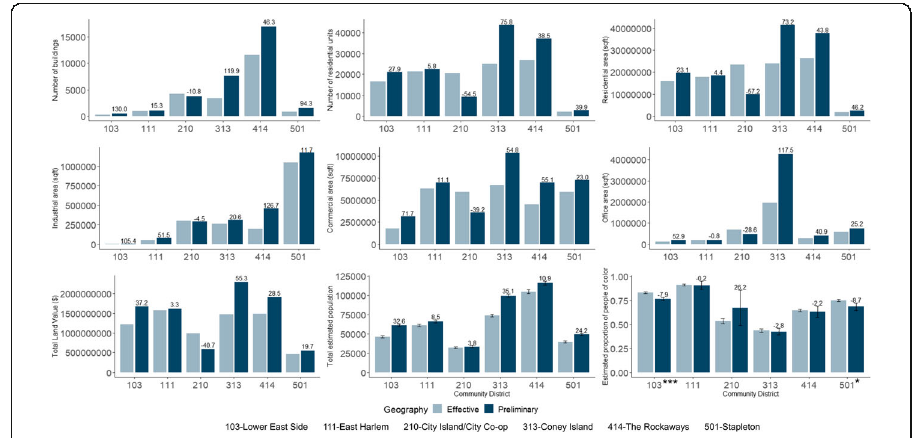
Fig. 6 Increase in exposure due to the redrawing of FEMA ’ s SFHA. Error bars represent the Standard Error of those variables that correspond to ACS estimates, and asterisks indicate the statistical significance of the indicators showing p-values below 0.01 (***), 0.05 (**) and 0.1 (*). No asterisk means that there is no statistically significant difference in exposure. Labels on top of each second bar indicate the %